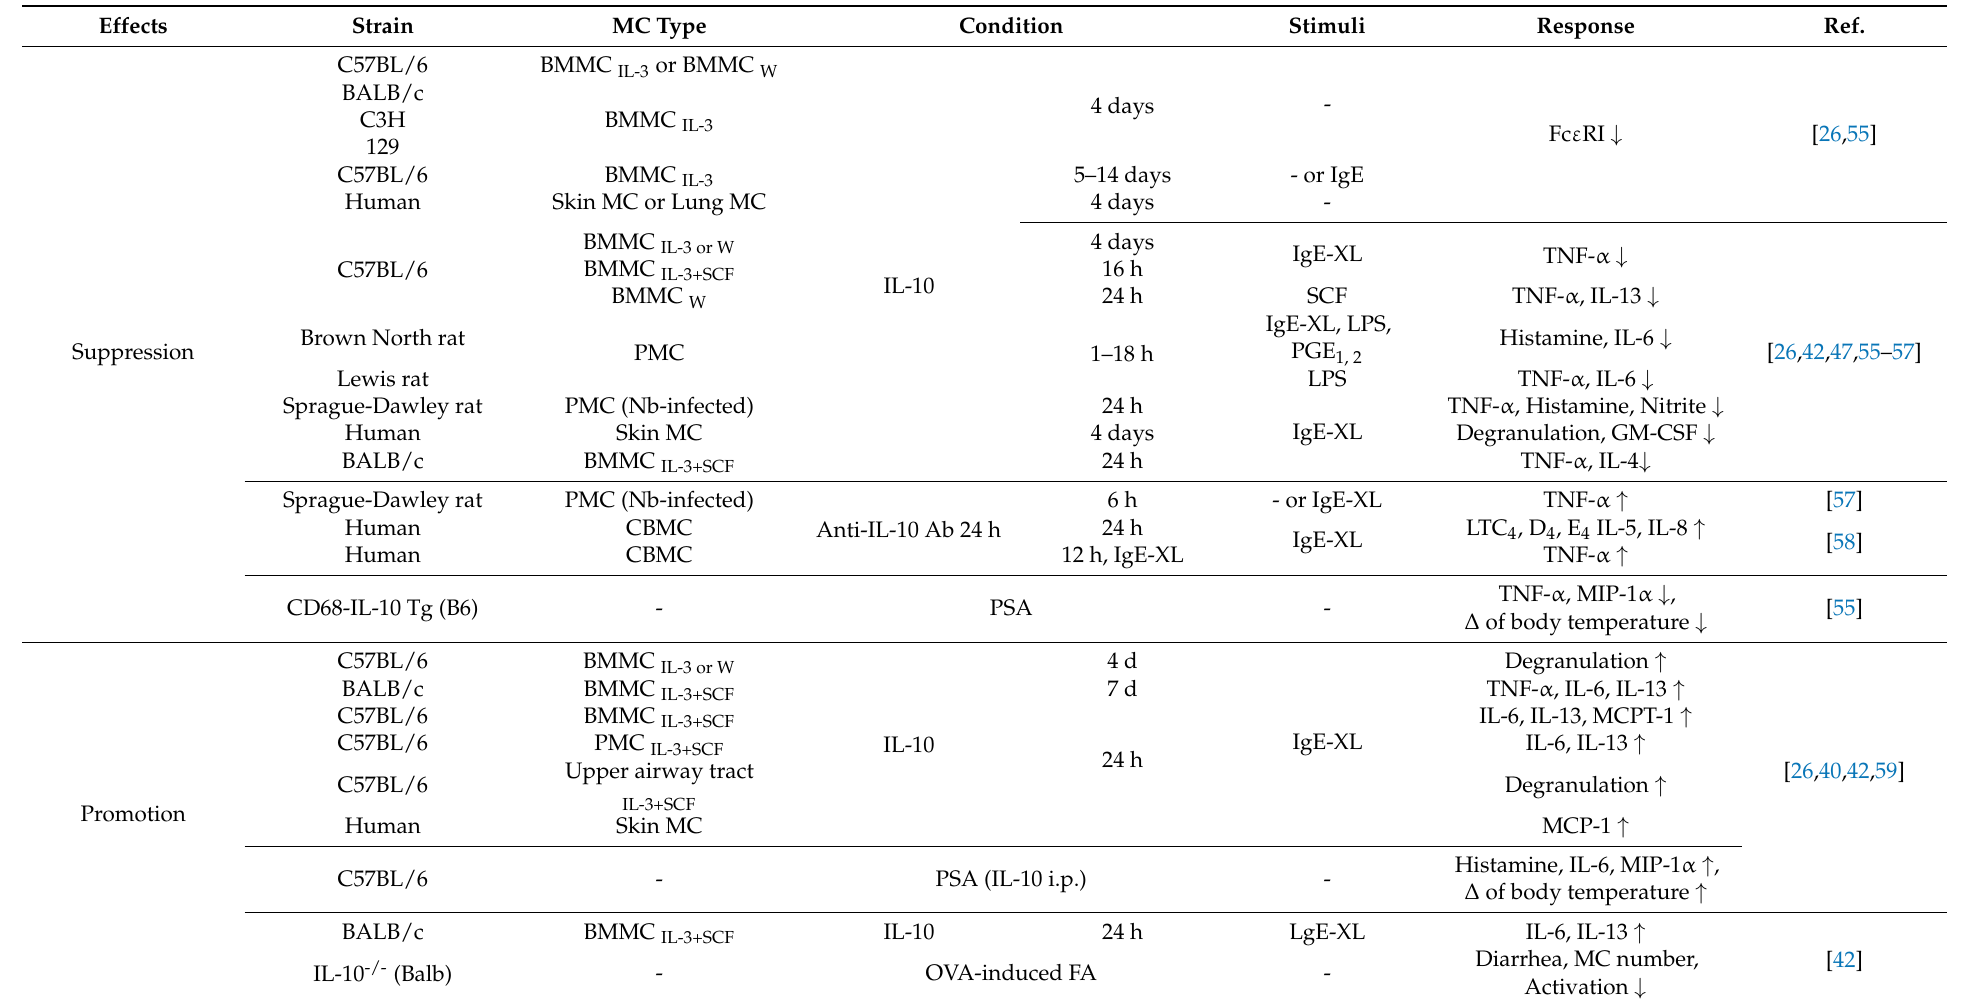
Table 2. Effects of IL-10 on function of